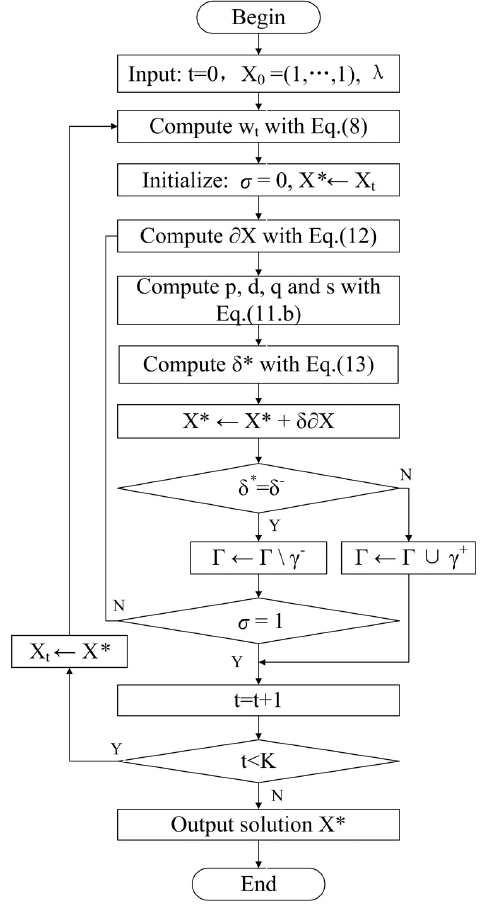
Fig. 1. Flow chart of the IRW-L 1 = 2 algorithm.